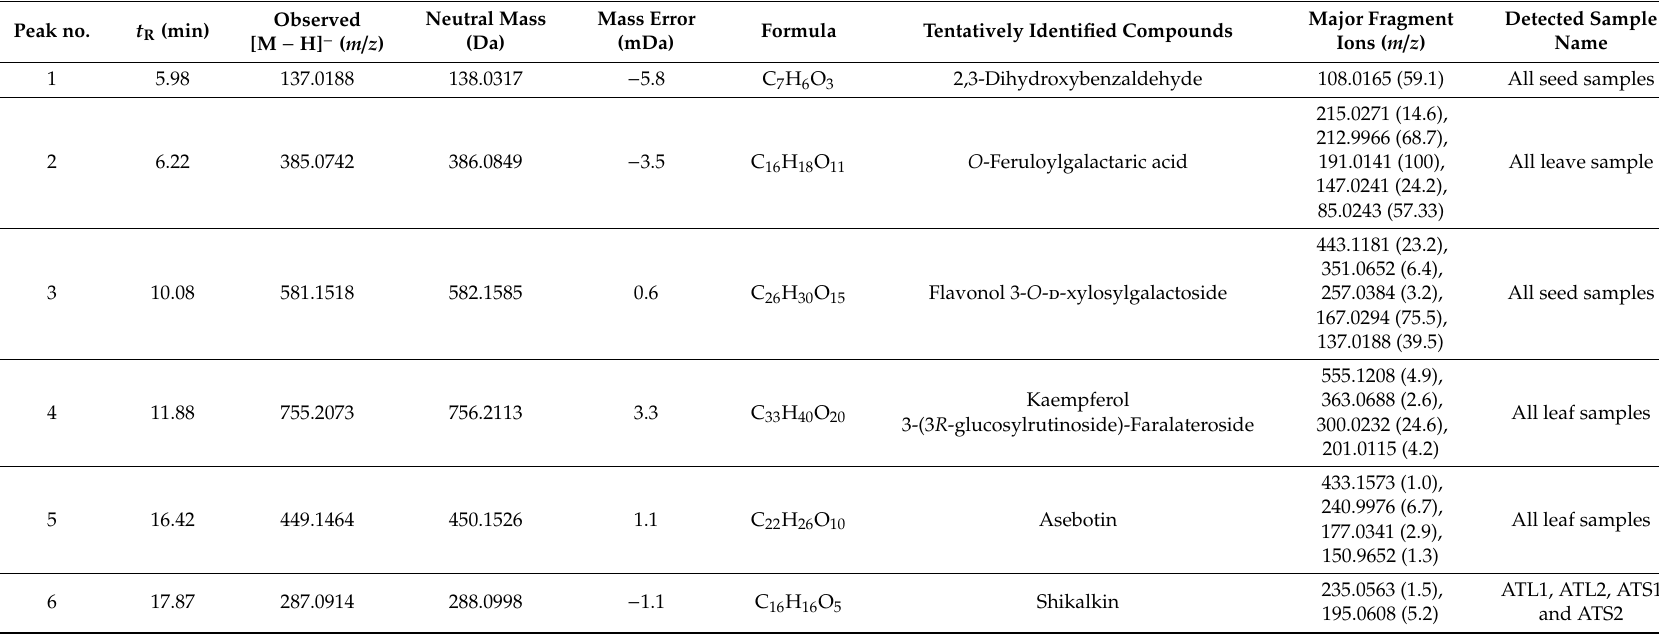
Table 2. Characteristic mass information of compounds tentatively identified in two Amaranthus species by UPLC-PDA / ESI-Q-TOF / MS. Peak